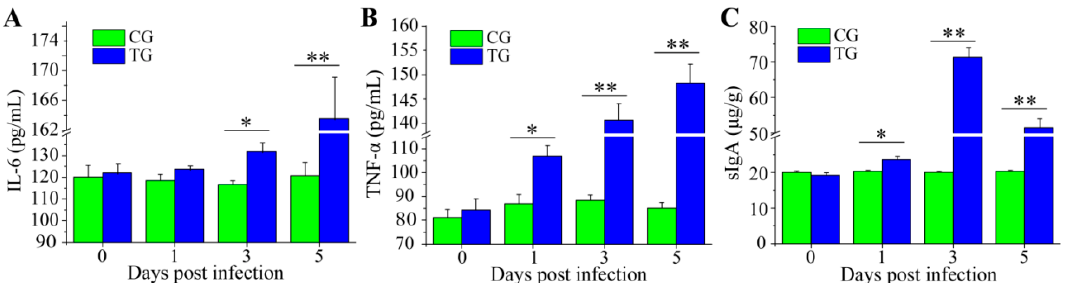
Figure 4. Immune response to C. perfringens type C infection. Serum concentration of pro-inflammatory cytokines IL-6 ( A ), TNF- α ( B ), and the fecal levels of sIgA ( C ) at 0, 1, 3, and 5 dpi were evaluated by ELISA. Each sample was assayed in three replicates. Values are presented as mean ± SE (* p < 0.05; ** p < 0.01).